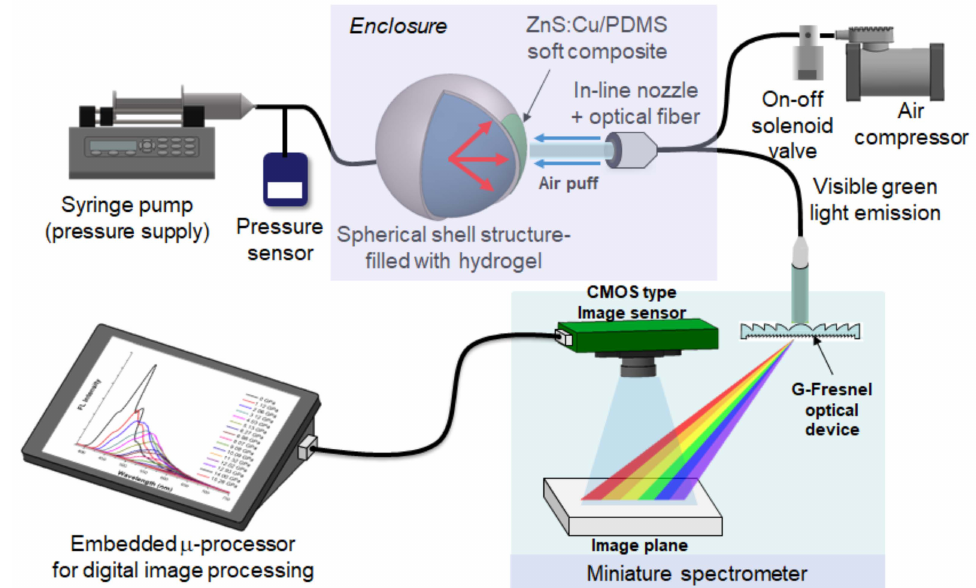
Figure 10. Schematic of the standalone opto-mechanical sensory system based on mechano-luminescence and the miniature spectrometer.